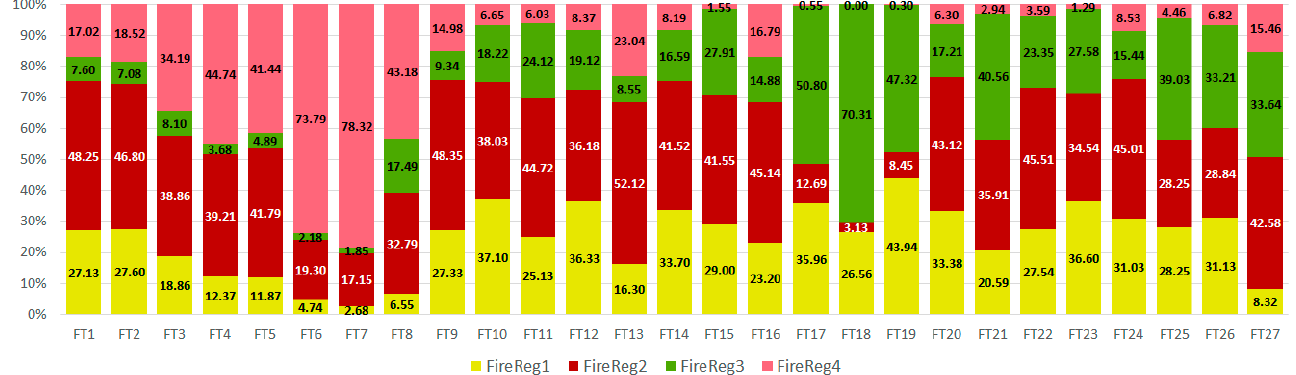
Figure 4. Percentage of each fire regime (FireReg) that comprise each fuel type (FT). Numbers indicate the percentage of each fire regime for each fuel type.